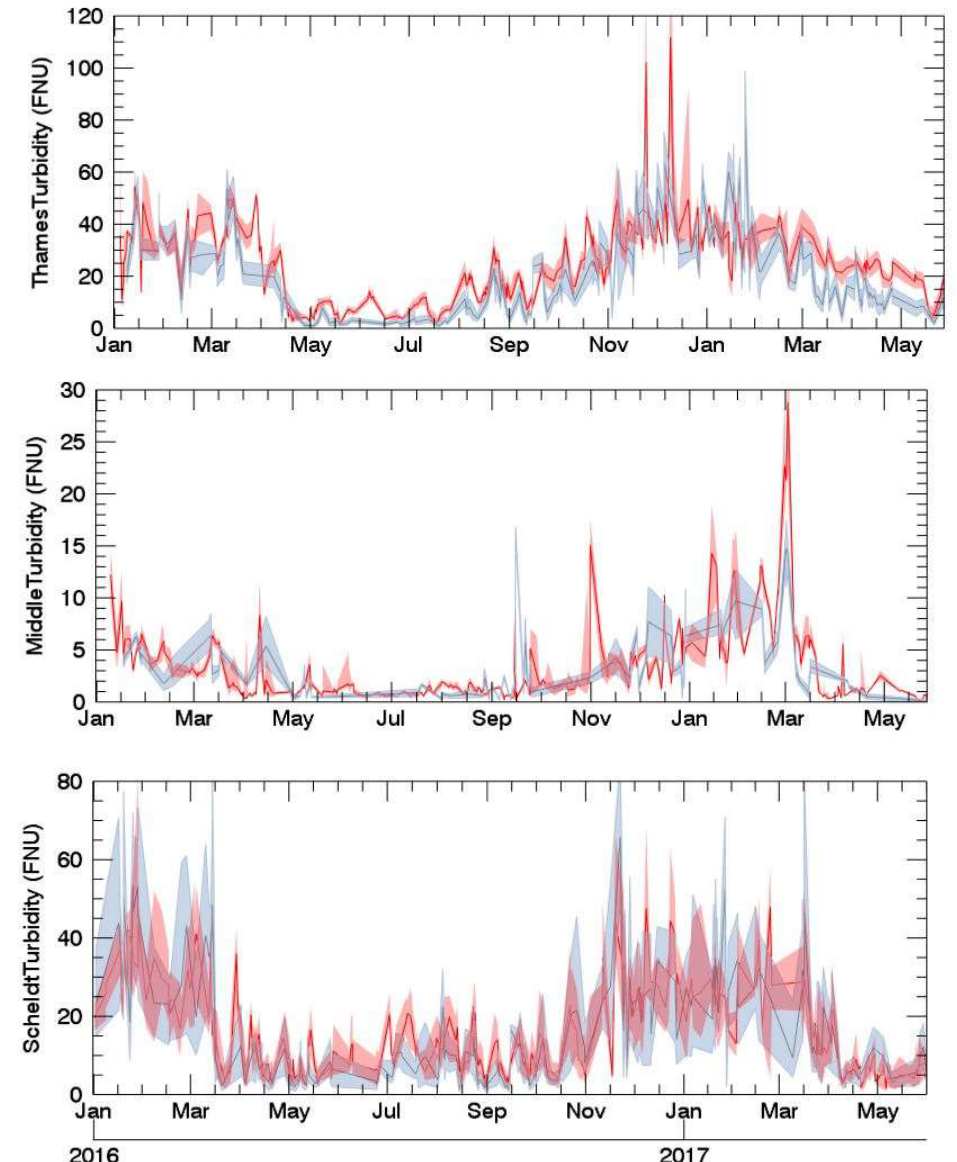
Figure 8. Time series of PROBA-V (grey) and MODIS (red) derived turbidity data from January 2016 to July 2017 for the subregion near the outlet of the Thames River ( top ), the middle of the Soutern North Sea ( middle ), and near the outlet of the Scheldt River ( bottom ). The light color around the solid lines show the IQR range (light grey for PROBA-V and light red for MODIS).